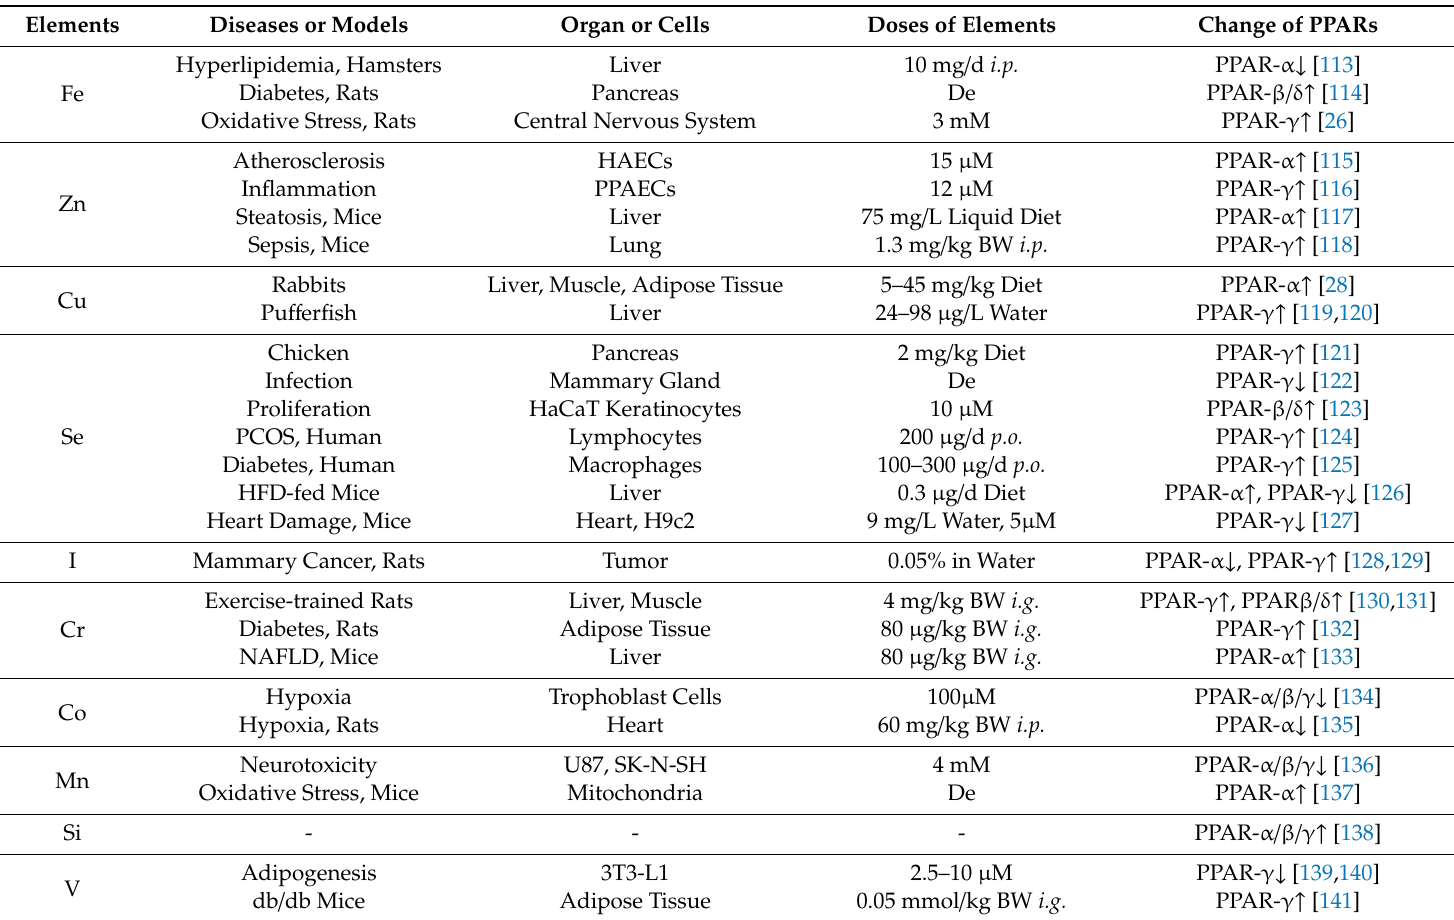
Table 2. E ff ects of trace elements on PPARs modulation in multiple diseases and